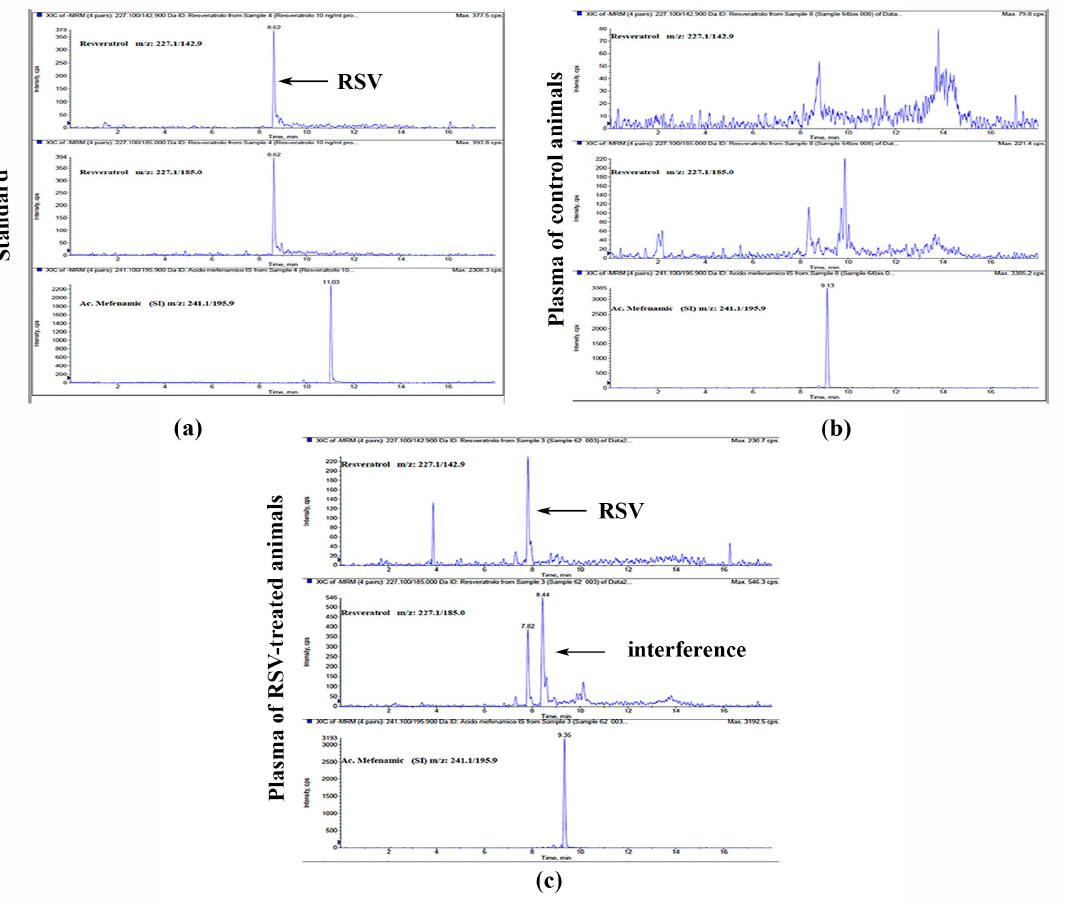
Figure 2. HPLC-MS/MS extracted chromatograms for RSV and Mefenamic acid (IS) of: ( a ) standard solution at 10 ng/mL concentration; ( b ) plasma of control mice; ( c ) plasma of mice treated with RSV.